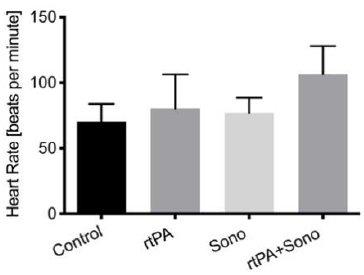
Figure A2. Heart rate (HR) of the groups (control Group n = 3; treatment groups (2–4); each n = 6). The means and SD of the HR are plotted as a column bar graph.